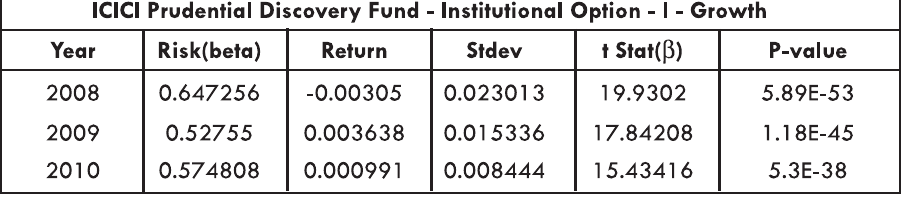
Table 7 : Risk and Returns of ICICI Prudential Discovery Fund - Institutional Option - I - Growth Scheme during the Study Period (2008 to